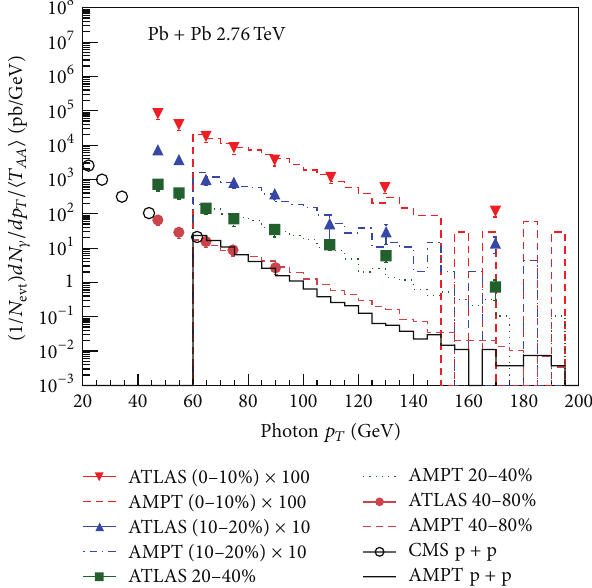
Figure 3: Transverse momentum spectra of prompt photons for 0– 10%, 10–20%, 20–40%, and 40–80% Pb + Pb collisions (scaled by 1/𝑇 𝐴𝐴 ) and p + p collisions at 2.76 TeV, scaled by different factors for easier viewing, where the histograms represent the AMPT spectra, while the symbols represent the data from ATLAS [43] and CMS experiment